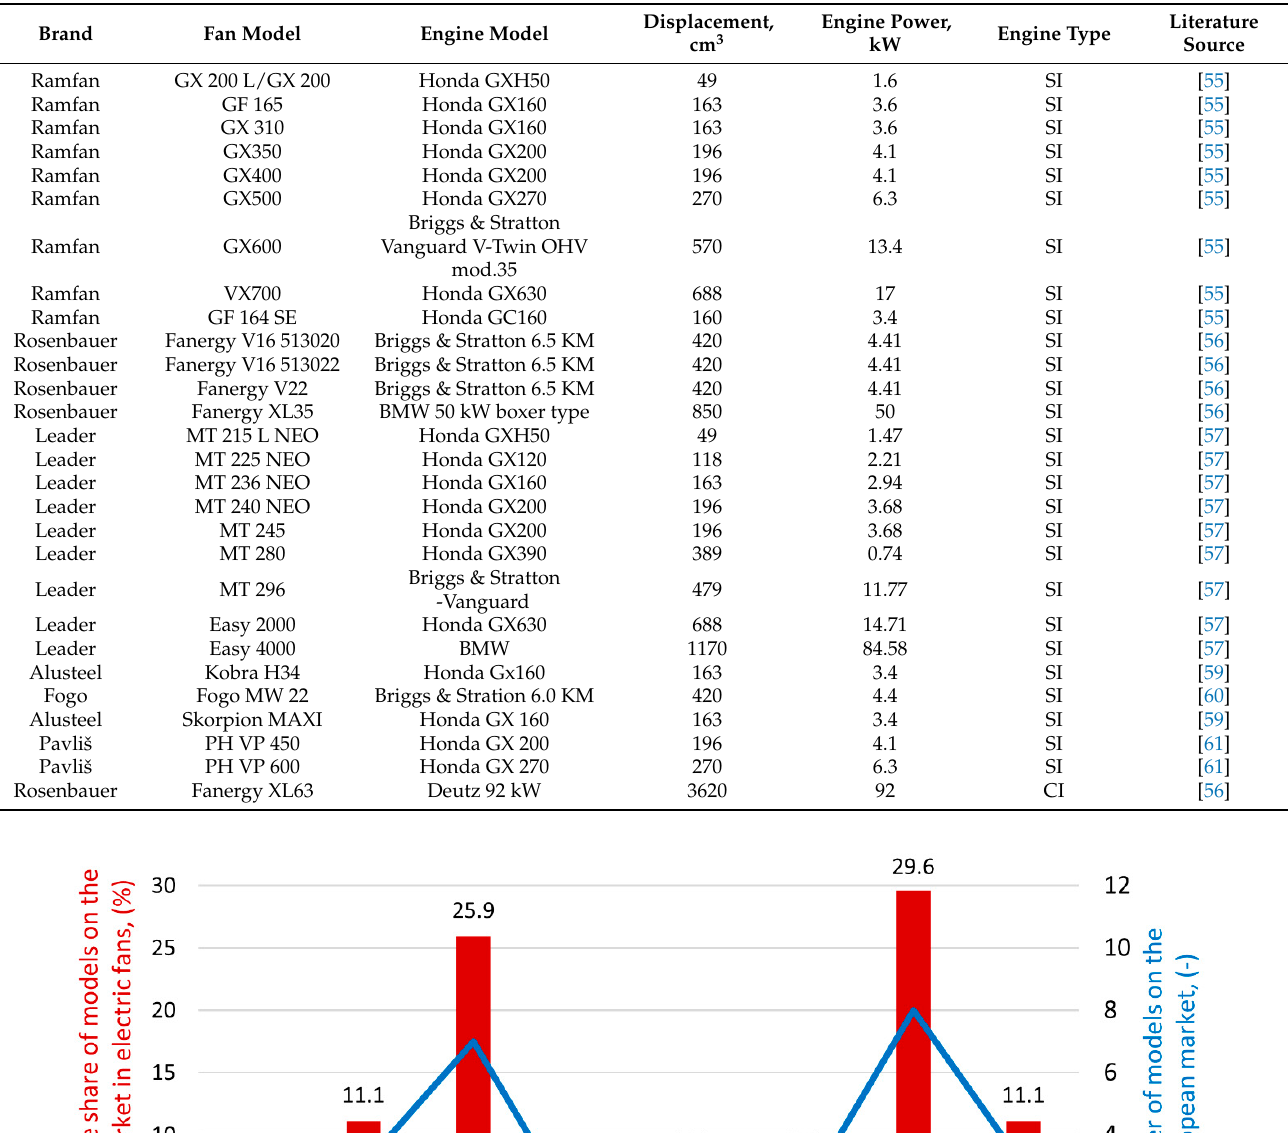
Table 2. Mobile positive pressure ventilation fans with internal combustion power units available on the European market.